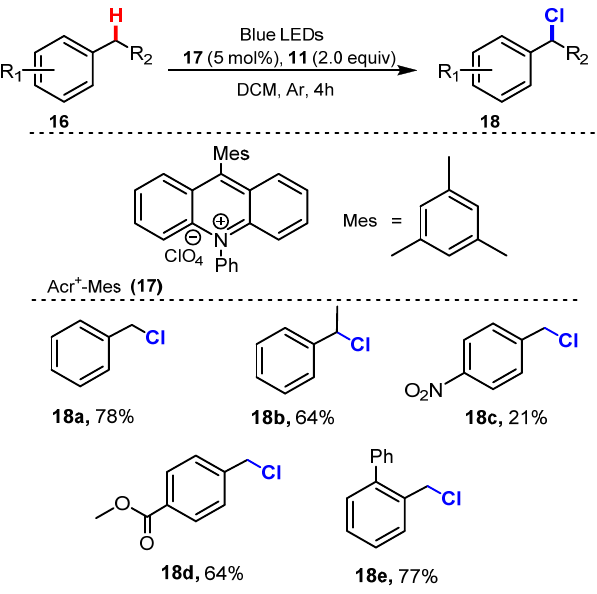
Scheme 6. Visible-light-catalyzed benzylic C-H bond